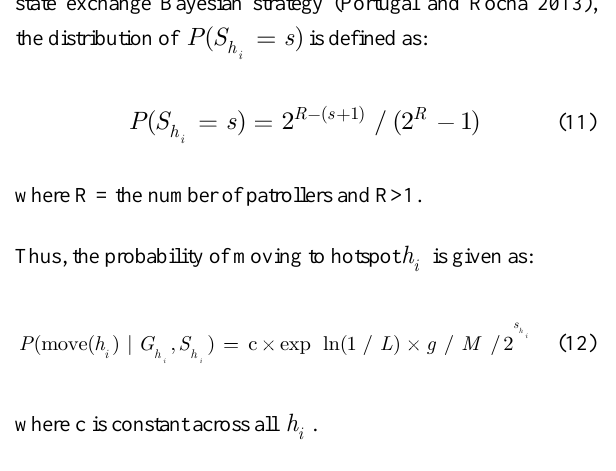
Figure 1. Map of Camden